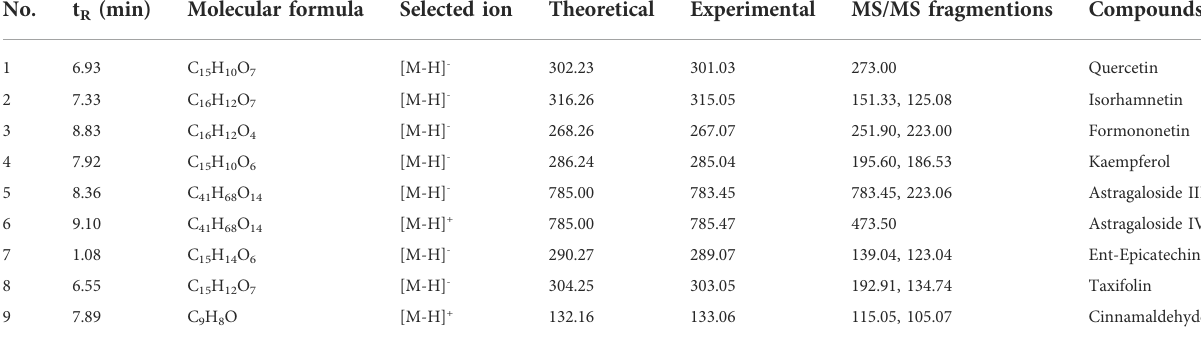
TABLE 3 Identi fi cation of in-blood ingredient in HGWD by UPLC-QTOF-MS data. No.